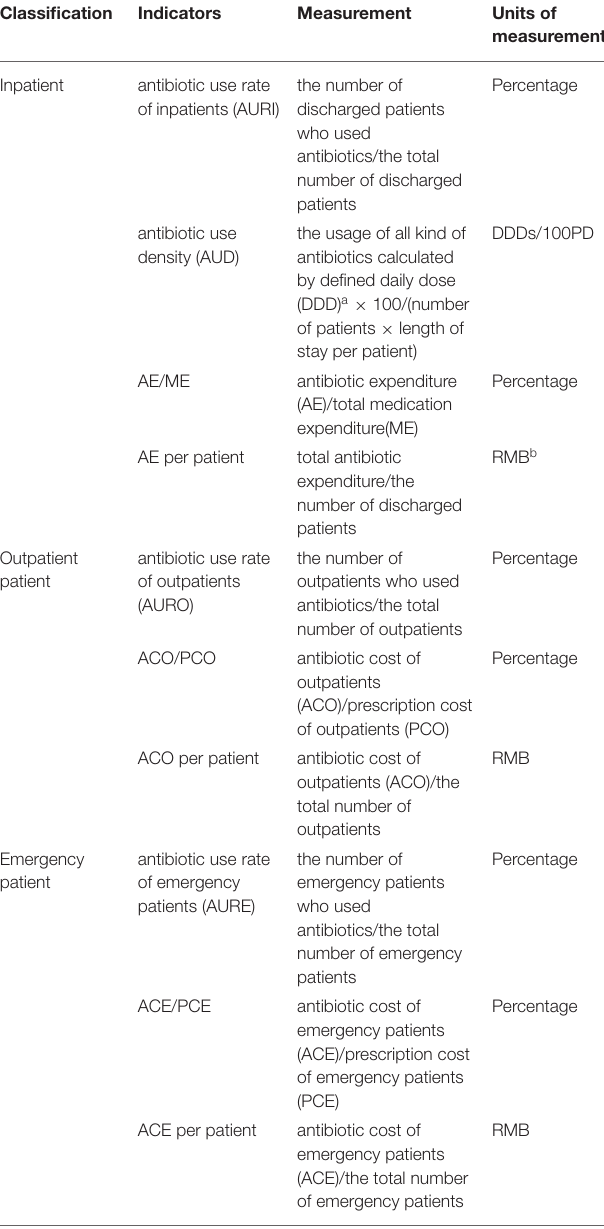
TABLE 1 | Study outcome